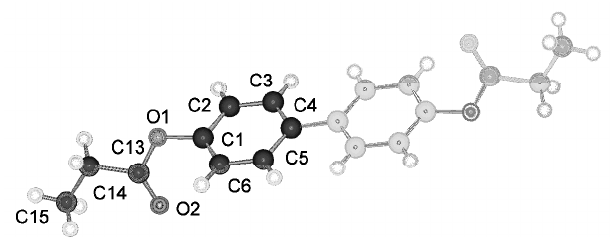
Figure 19. Asymmetric unit of BP-2 (half a molecule) and the corresponding symmetric unit of the molecule. Both halves are connected by an inversion center between the two phenyl rings. Note the two phenyl rings are coplanar. Also represented are the packing arrangements on the a,c-plane and down the molecular